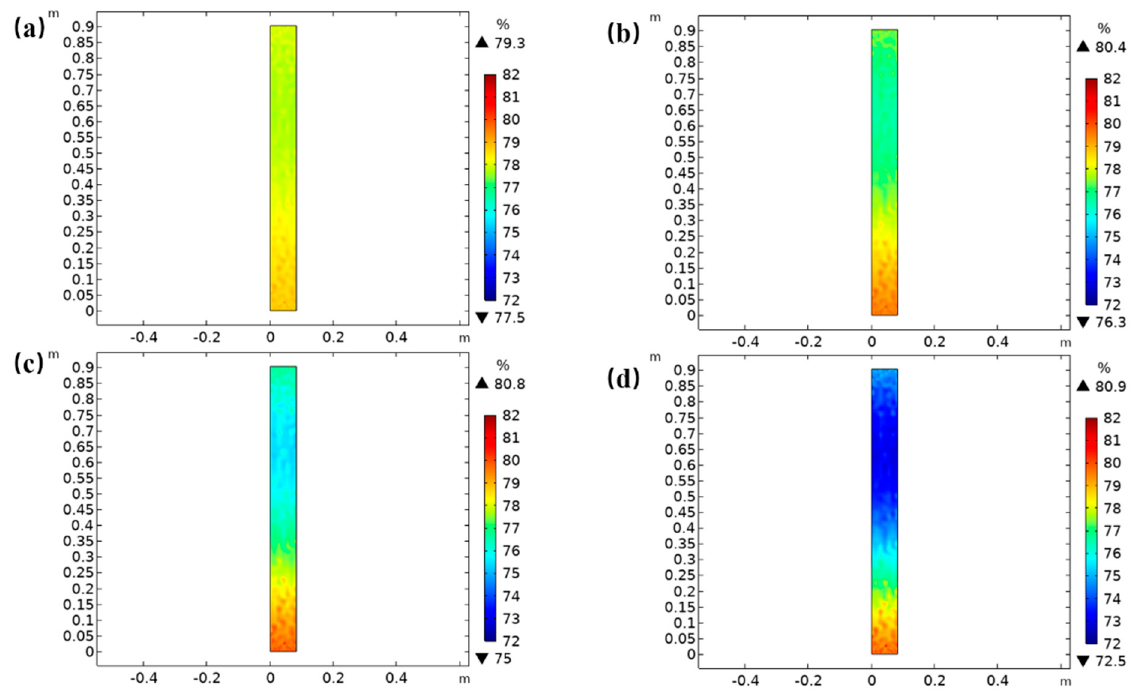
Figure 9. Difference in SOC on the negative diaphragm side at the charging cut off moment for different operating conditions at 25 °C. ( a ) 0.5 C; ( b ) 1 C; ( c ) 1.5 C; ( d ) 2 C.